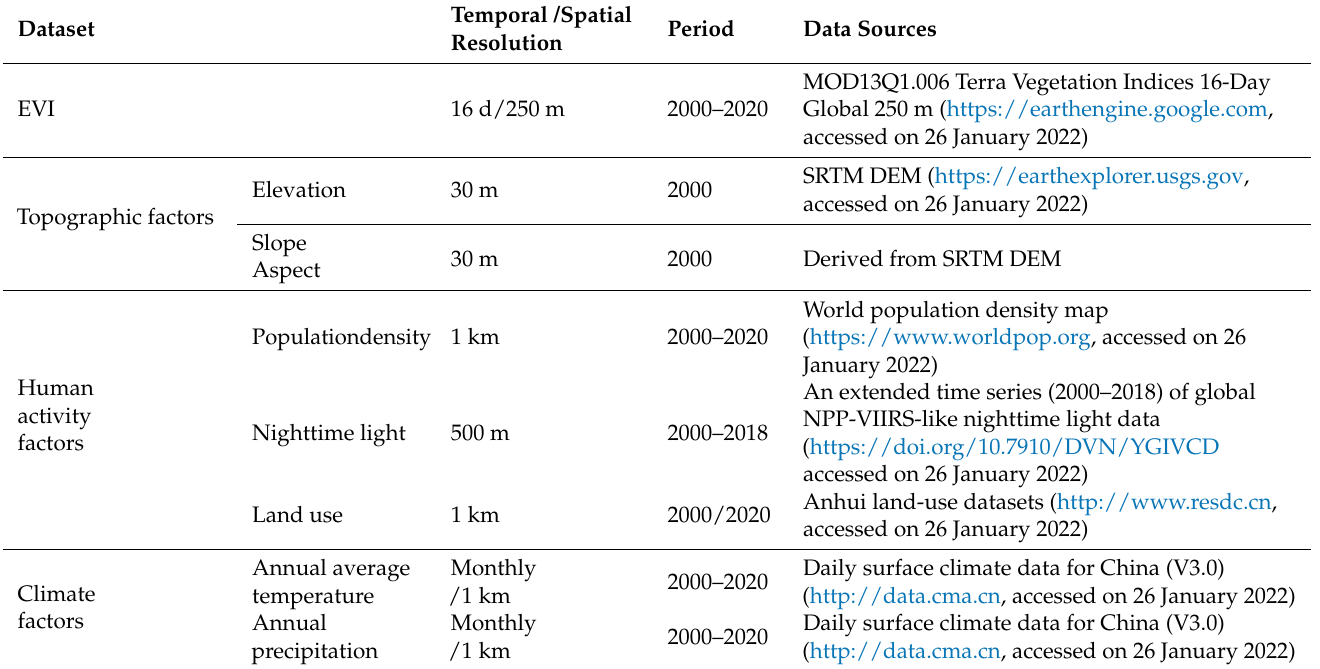
Table 1. Basic information of the study data.